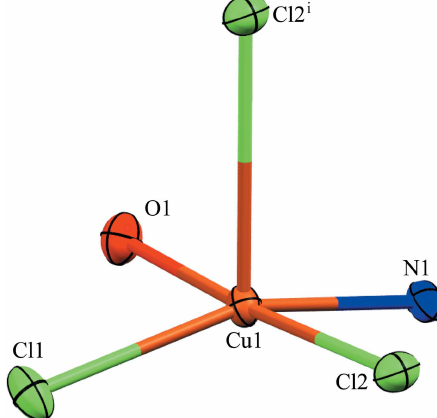
Figure 2 The distorted square-pyramidal geometry about Cu1 [symmetry code: (i) (cid:4) x + 1, (cid:4) y + 1, (cid:4) z ]. See Fig. 1 for display details.